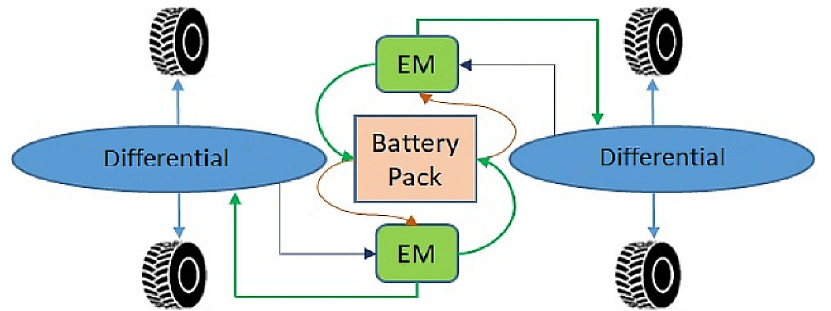
Figure 9. Adopted schematic layout of an electric car.